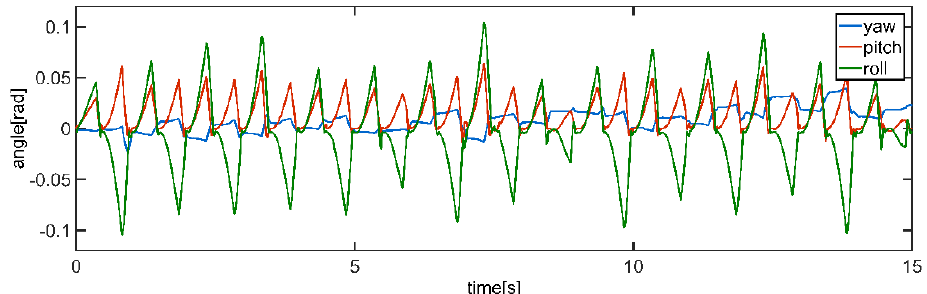
Figure 15. Attitude angles of the body.